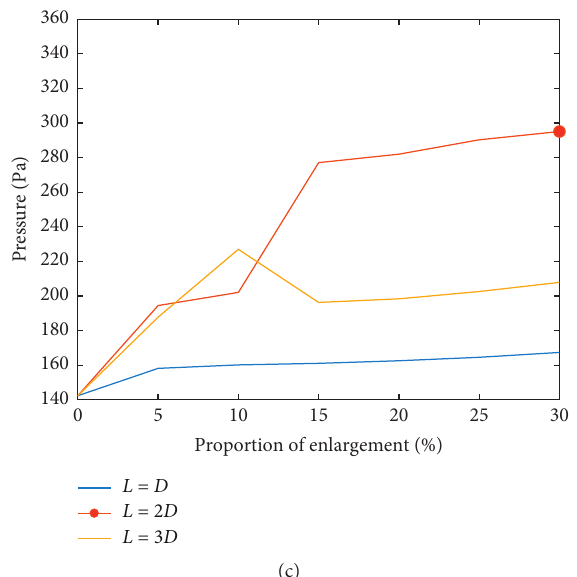
Figure 4: Pressure distribution (A, B, and C each shows pressure of different locations after implantation of enlarged vessels with different length of enlarged area varies from L � D to L � 3 D , the maximum pressure value within each group is marked by red circle). (a) Pressure (A). (b) Pressure (B). (c) Pressure (C).